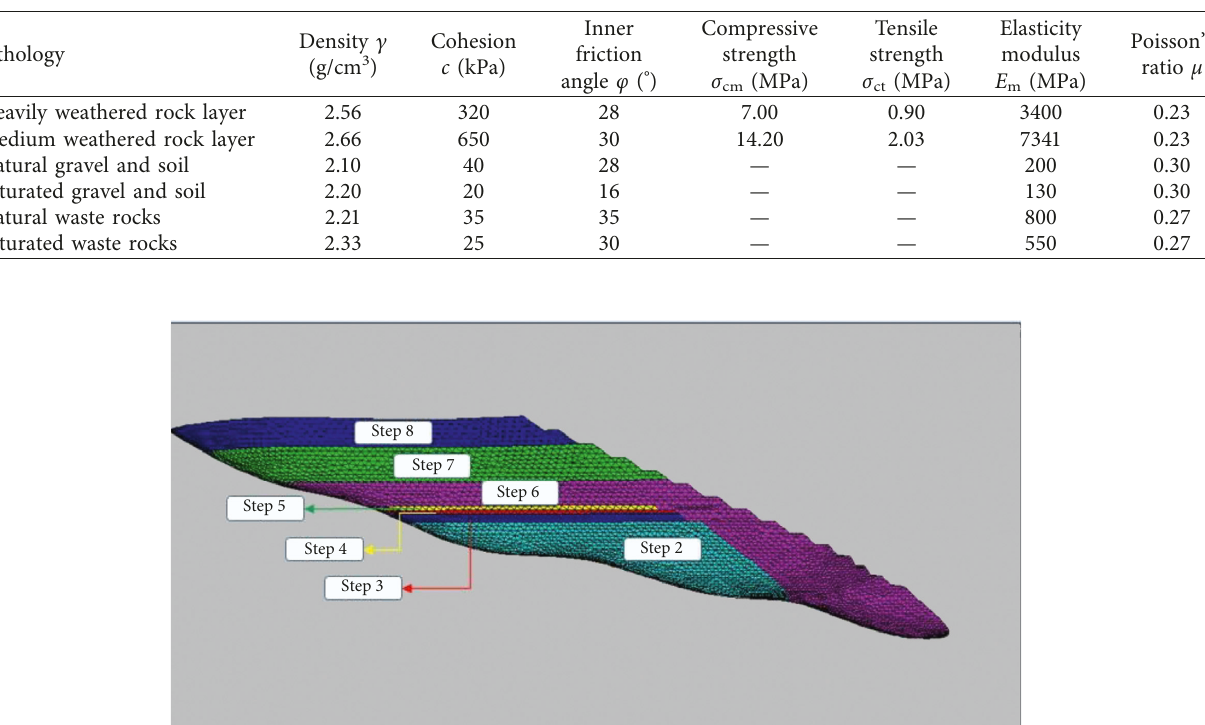
Table 7: Physical and mechanical parameters of the sample rocks from waste dump.